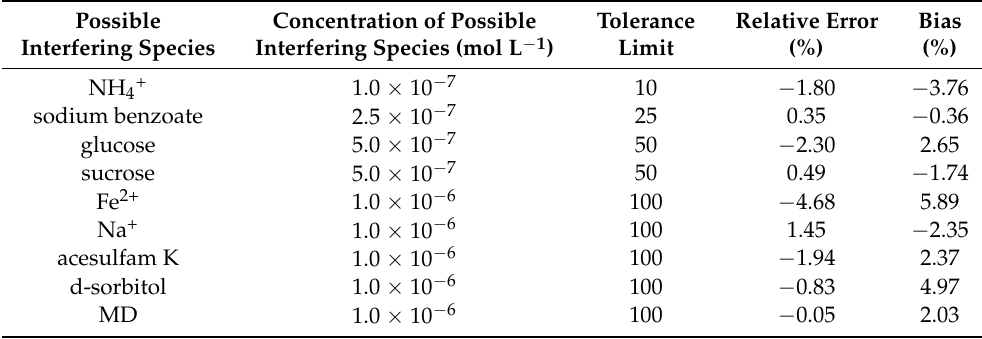
Table 3. The influence of possible interfering species on the detection of 1.0 × 10 − 8 sodium